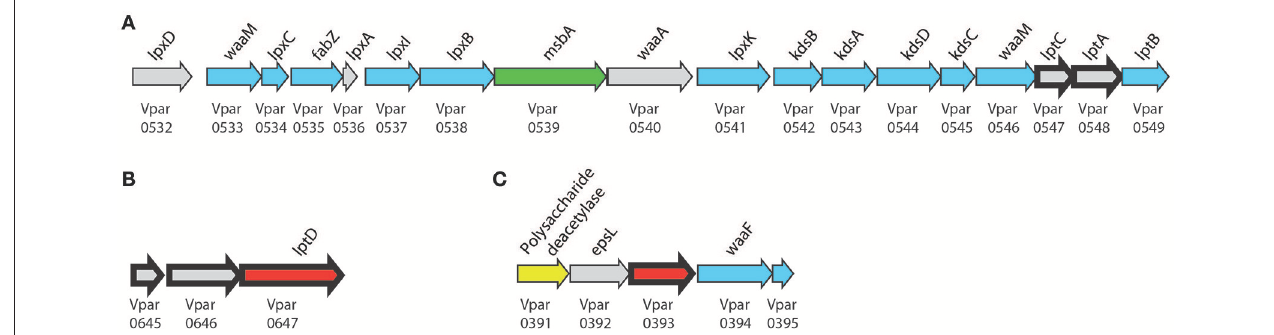
FIGURE 5 | Lipopolysaccharide biosynthesis clusters. Biosynthesis clusters found within V. parvula of (A) core biosynthetic and transport machinery, (B) conserved lptD cluster, (C) proposed LPS modification cluster. Bold arrows represent peptides detected in the OM. Localization is presented by color: Gray, unclear; Blue, cytoplasmic; Green, IM; Yellow, Periplasmic; and Red, OM. Genomic coordinates are (A) , CP001820.1:650916–670828 ( + ); (B) CP001820.1:780878–784136 ( + ); (C) , CP001820.1:477425–481382 ( +